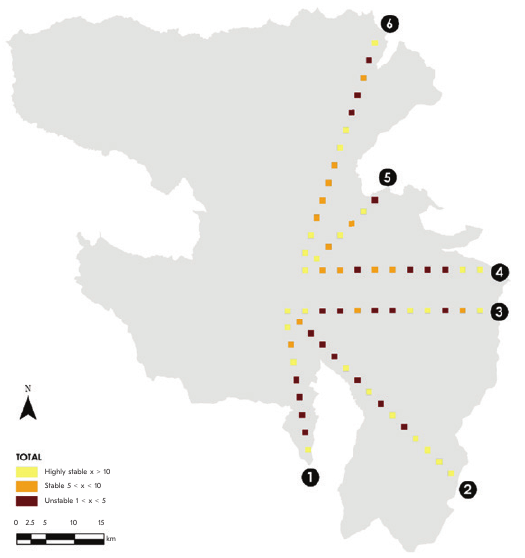
Figure 8. Total landscape stability index